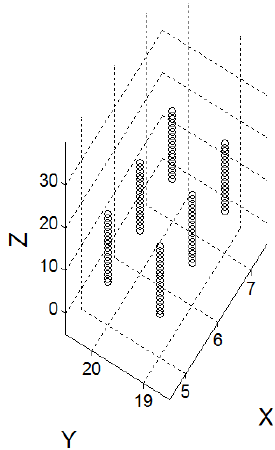
Figure 5. A structure leads to a wrong skeleton for the modified algorithm.